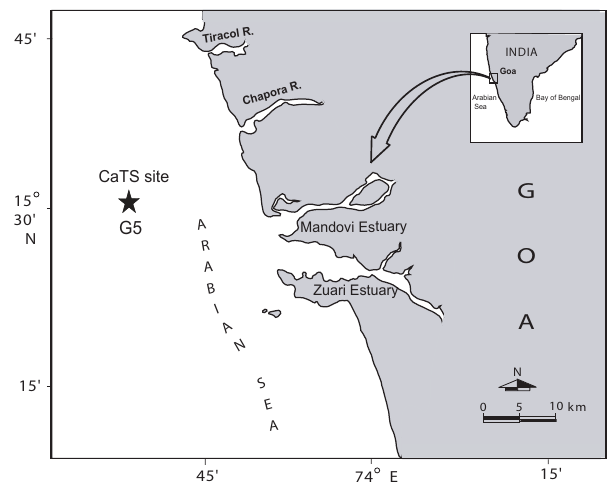
Fig. 1. Figure 1. Geographical location of the studied site (G5) over the western continental shelf of